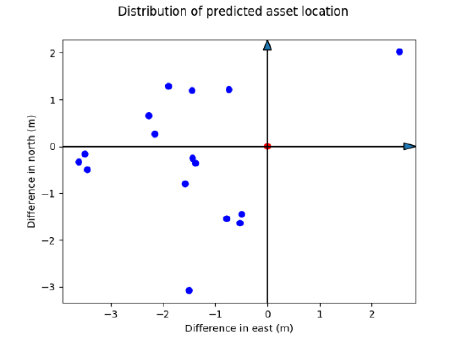
Figure 8. Distribution of predicted location compare to ground truth